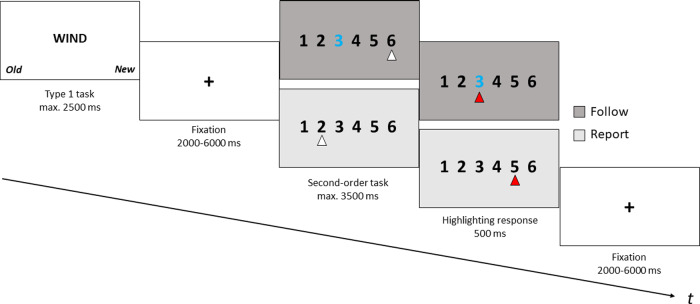
Schematic trial representation for the first retrieval task (stimuli are not to scale). Each trial consisted of two parts: first, participants categorized a presented word stimulus either as old (presented in the previous encoding task) or new (not having been presented before) (Type 1 task). Subsequently, they either indicated their subjective confidence (“Report” condition, shown in white) or placed the cursor at a color-coded position on the scale (“Follow” condition, grey) (Second-order task). The second retrieval task was similar, only here, the second-order task consisted entirely of “Report” trials, and the fixation period between task screens was shorter (1000 ms).